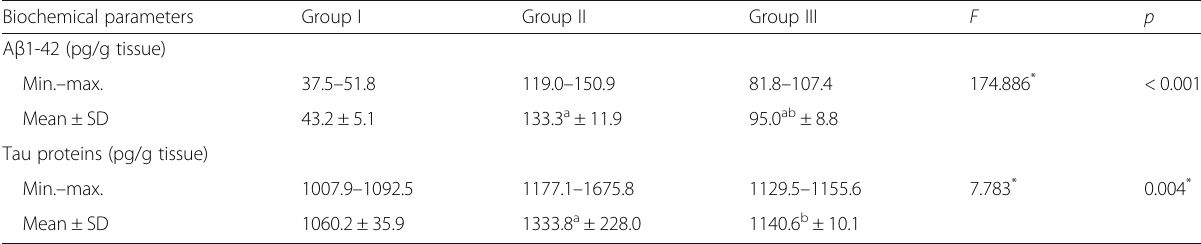
Table 1 Comparison between the three studied groups according to β -amyloid peptide 1-42 (A β 1-42) (pg/g tissue) and tau proteins (pg/g tissue) Biochemical parameters